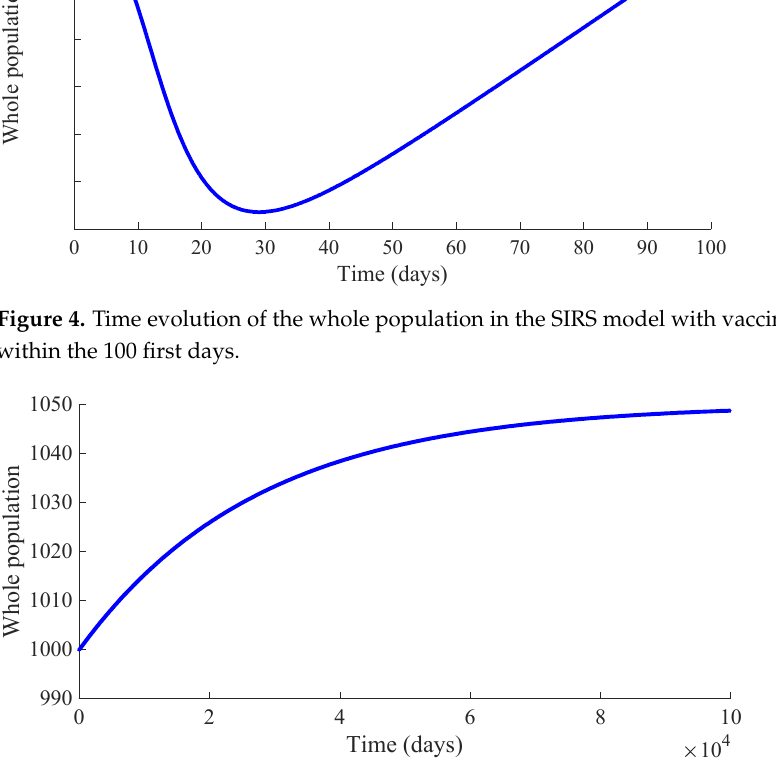
Figure 5. Time evolution of the whole population in the SIRS model with vaccination and treatment along 100,000 days.